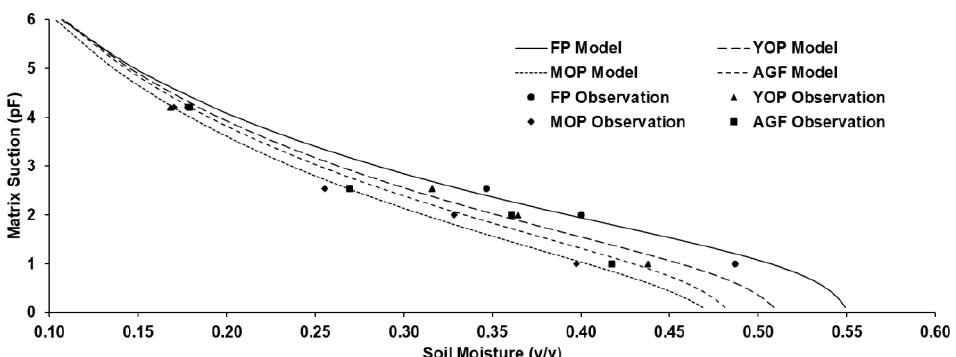
Figure 2. Soil water retention curve for each land use. Table 2. SWRC best-fit parameters and S value.